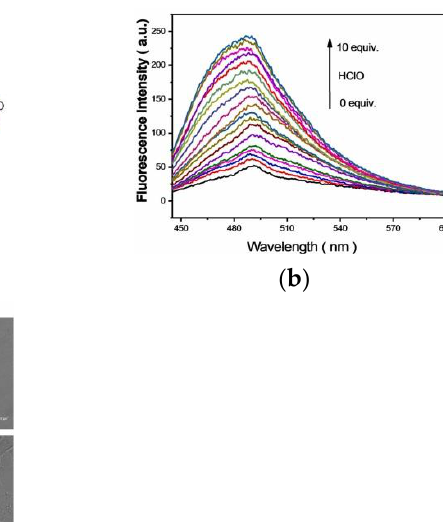
( d ) Figure 33. ( a ) Structure of BBHP; ( b ) Fluorescence imaging in HeLa cells; ( c ) Fluorescence imaging in different cancer cells; ( d ) Fluorescence imaging in normal and tumor tissues. Reproduced with permission from [139]. Copyright 2022 American Chemical Society. 9. Fluorescent Probe for Detecting Hypochlorous Acid (HOCl) Hypochlorous acid (HClO) is one of the important ROSs in the living system and is related to many physiological and pathological processes [140,141]. For example, high expression of HClO can lead to risk diseases such as inflammation, cardiovascular dis- ease, tumor, and liver damage [142 – 146]. Several studies have shown that HclO acid may be abnormally expressed in tumors [147 – 152]. Therefore, monitoring the changes in HclO levels is of great significance in the diagnosis of malignant tumors.